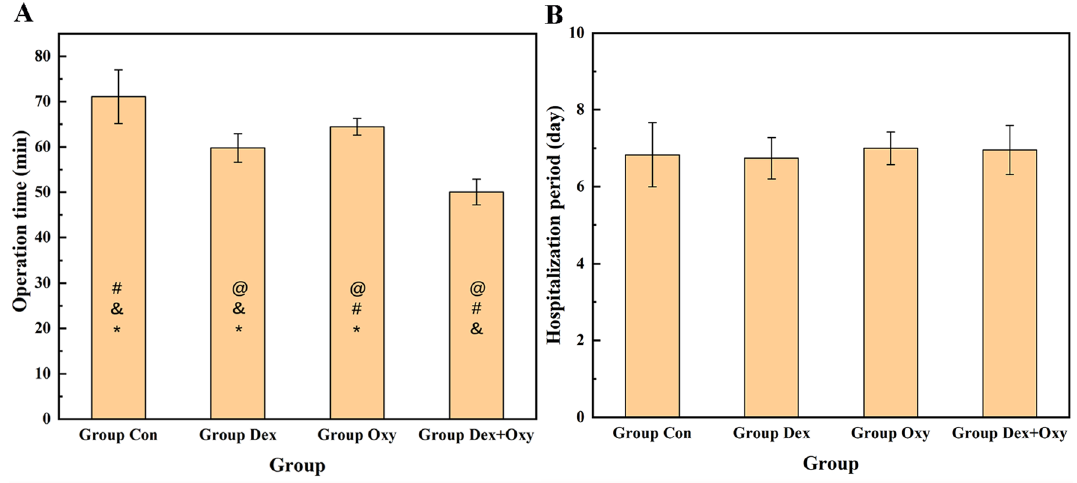
Figure 2. The results of operation time ( A ) and hospitalization period ( B ) in different groups. "@", "#", "&", "*" represent the difference was statistical when compared with Group Con, Group Dex, Group Oxy, and Group Dex + Oxy,